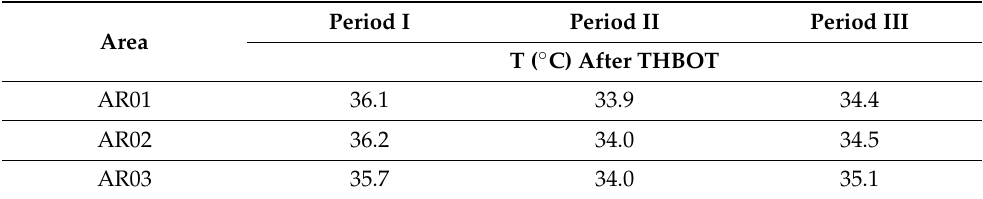
Table 2. Average temperature of the studied areas obtained for the representative patient taken before and after THBOT during three periods of treatment.